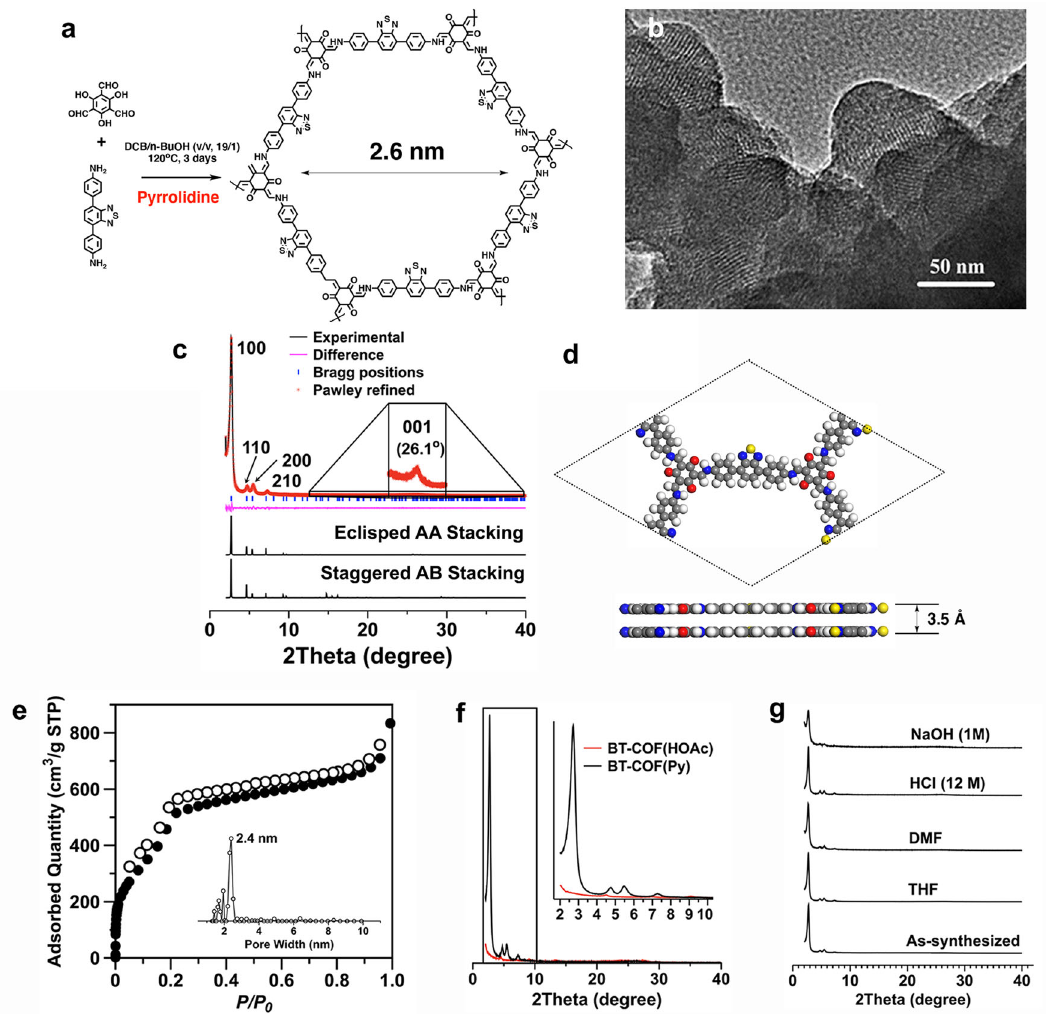
Fig. 1 PXRD patterns, crystalline structure, TEM image, and porous properties. a Synthesis of BT-COF by an aldimine reaction in a mixture of o - dichlorobenzene (DCB), n -butanol ( n -BuOH), and pyrrolidine. b HR TEM image of BT-COF. c PXRD patterns of the experimentally observed (black) and Pawley re fi ned (red) BT-COFs with their re fi nement difference (pink), and the simulated patterns for eclipsed AA- and staggered AB- stacking modes. d Lattice structure of BT-COF at top and side view (gray: carbon; white: hydrogen; blue: nitrogen; red: oxygen; yellow: sulfur). e Nitrogen adsorption (solid circle) and desorption (open circle) isotherm pro fi les and pore-size distribution (inset) of BT-COF obtained by nonlocal density functional theory modeling on the N 2 adsorption curve. f PXRD patterns of BT-COF synthesized with pyrrolidine (black curve) and 6 M HOAc